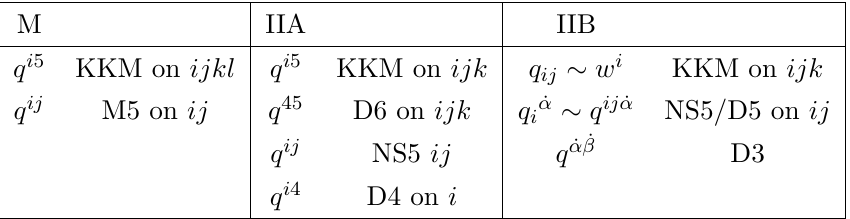
Table 5 . Partially wrapped branes (three-branes): q ab